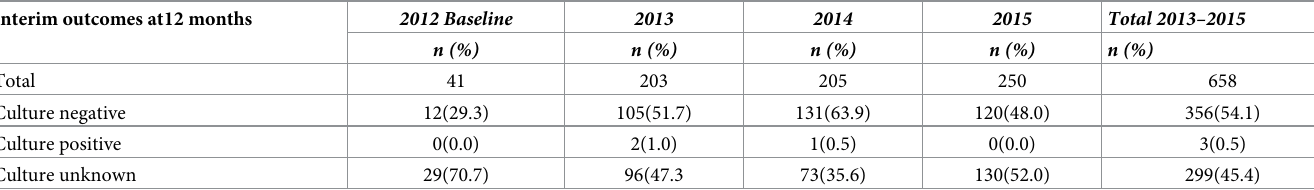
Table 4. Twelve-month interim outcomes for RR-TB/MDR-TB patients enrolled in 2012–2015.